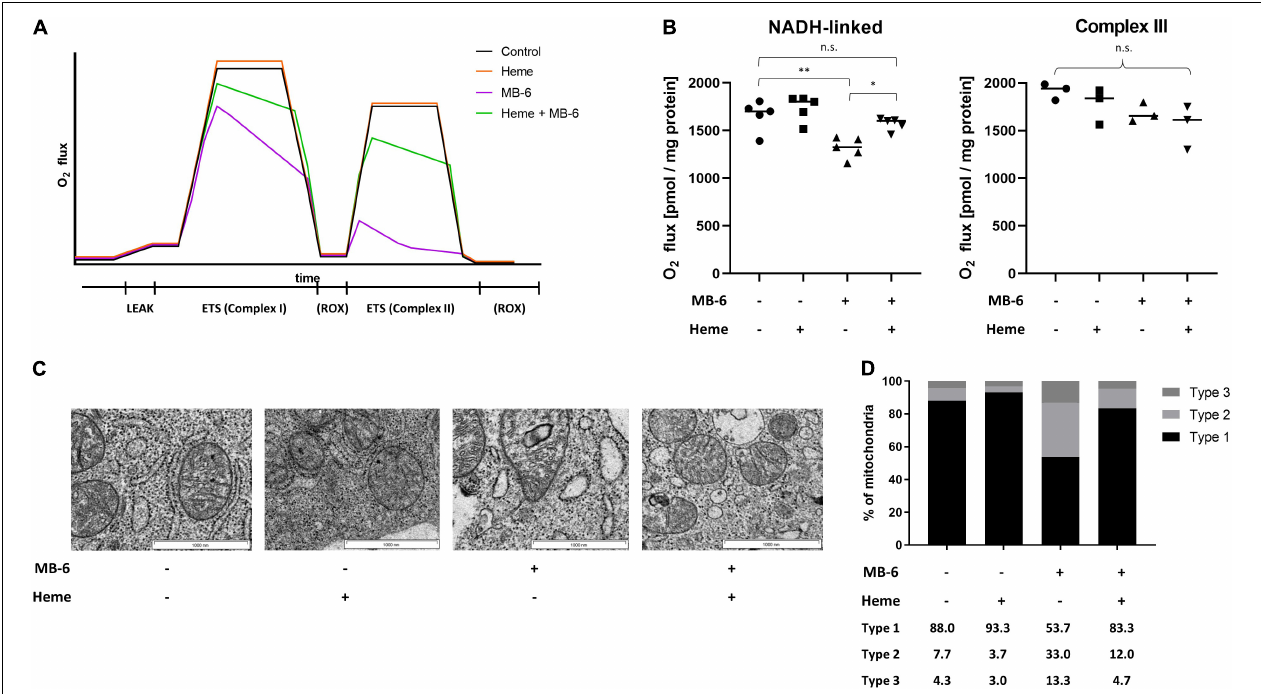
FIGURE 5 | MB-6 impaired mitochondrial function and structure are both strongly improved by methemalbumin supplementation. (A) Representative presentation of high-resolution respirometry with both NADH-linked and FAD-linked substrates. Respiration of control cells (black) and heme-treated cells (orange) are indistinguishable. MB-6 treatment (violet) results in lower initial maximum respiration and causes a steady decline in O 2 flux over time which carries over to succinate-linked respiration. Double treatment (green) significantly restores initial respiration and alleviates the continuous decline in O 2 flux. LEAK and ROX respirations are comparable in all four conditions. (B) NADH-linked peak respiration is strongly impaired by MB-6 treatment. Methemalbumin supplementation rescues the impairment almost entirely. Meanwhile, complex III-driven respiration fueled by an exogenous ubiquinol derivative remains unchanged by either treatment. ∗ p < 0.05, ∗∗ p < 0.01. (C) Electron micrographs reveal that mitochondrial ultrastructure is almost restored to control levels upon methemalbumin supplementation. (D) Quantitative analysis of mitochondria demonstrates a significant decline in type 2 and type 3 mitochondria close to control